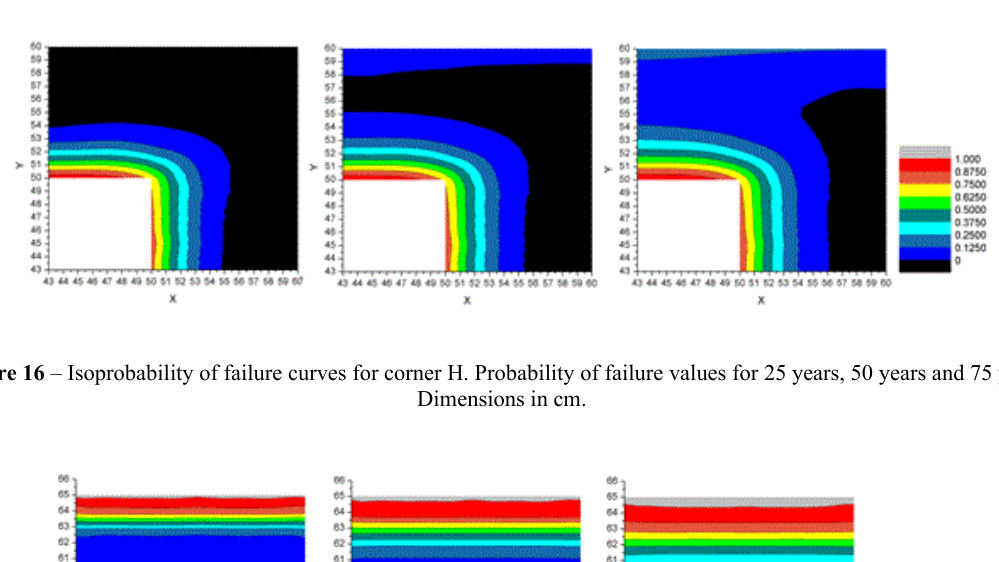
Figure 15 – Isoprobability of failure curves for corner A. Probability of failure values for 25 years, 50 years and 75 years. Dimensions in cm.